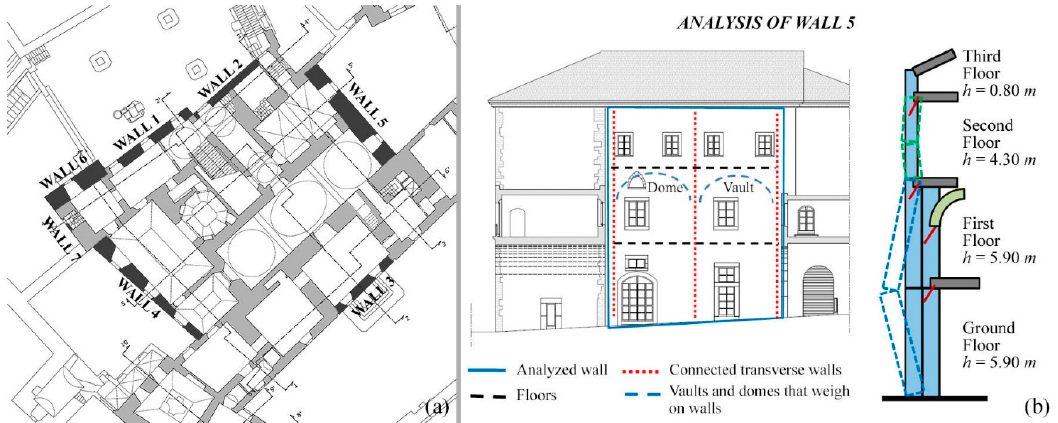
Figure 14. Identification of the walls analyzed by the kinematic linear analysis ( a ) and scheme for the identification of the forces and the structural mechanisms involved in the kinematic analysis of Wall 5 ( b ).